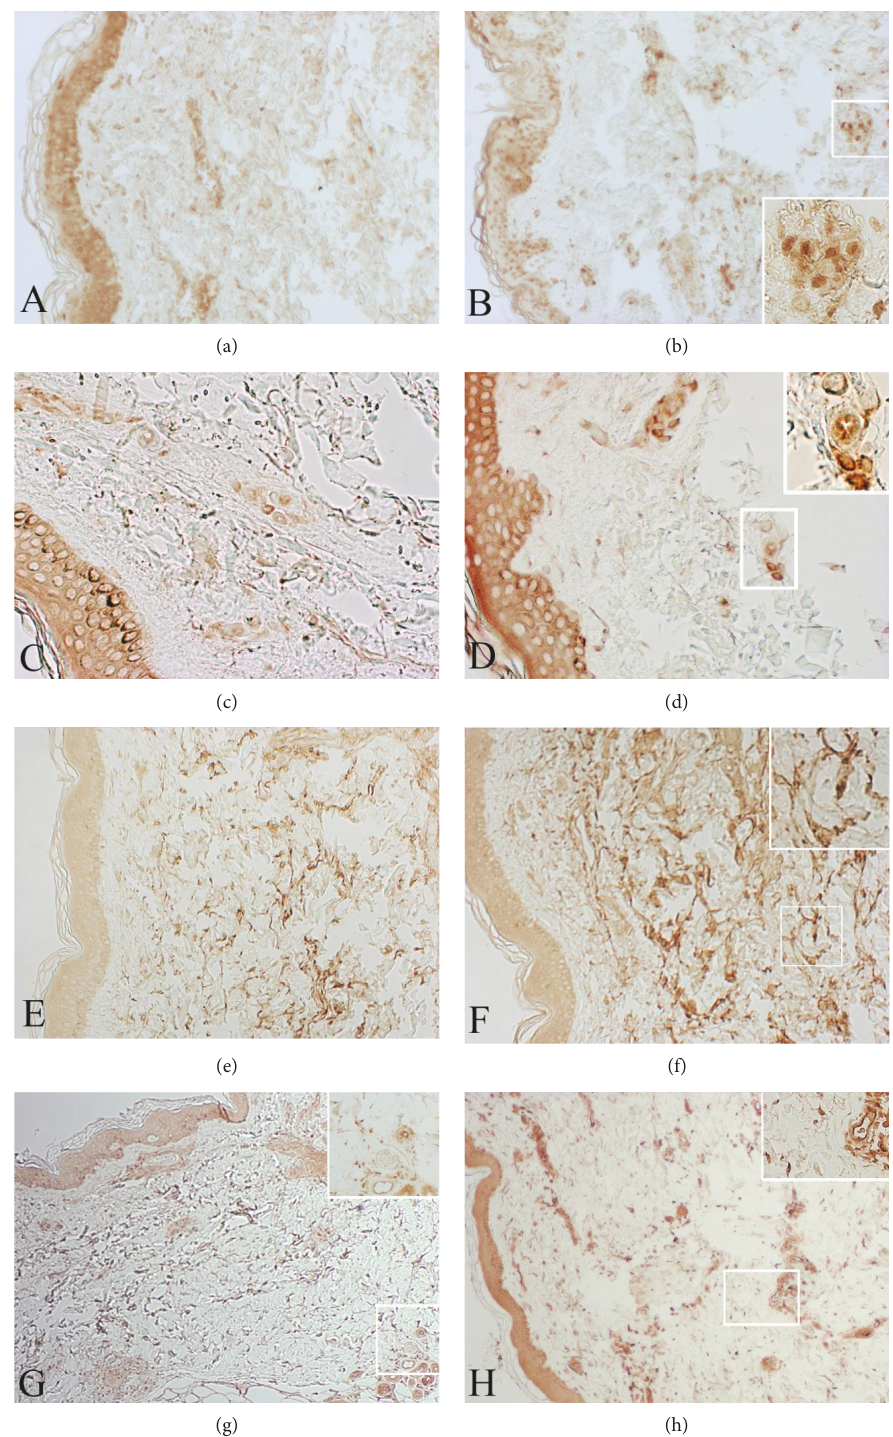
Figure 3: Skin biopsies from MDE patient (b, d, f, and h) and healthy donor (a, c, e, and g). M1 macrophages (iNOS positive) are present in MDE areas together with iNOS negative macrophages (b). No reaction is noticed in the middermis of control patients (a). A weak reaction for MMP-2 (c) and TIMP-2 (e) is detected on cell membranes in the middermis of a control subject. A positive reaction for MMP-2 (d) and TIMP-2 (f) is evident on the cell surface of middermal fi broblasts and in fl ammatory cells. A di ff use reaction for MMP-14 is localized in large areas of the middermis from MDE patient (h). A mild reaction for MMP-14 is present also on cell membranes in the middermis from a control subject (g). (a-b) Original magni fi cation × 100; (c-d) original magni fi cation × 200; (e-f) original magni fi cation × 100; original magni fi cation ×